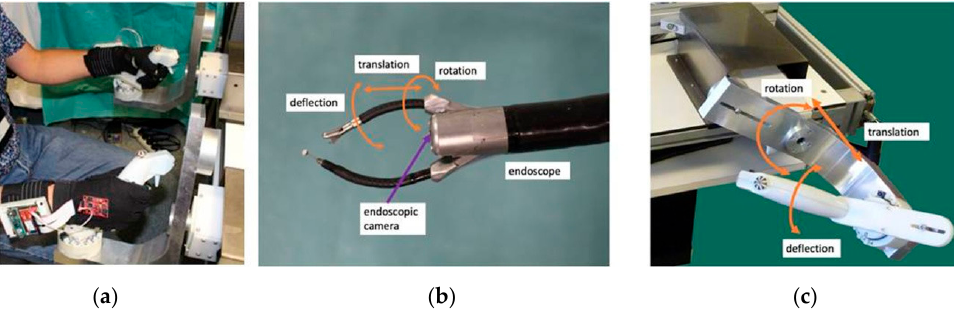
Figure 2. Expert wearing the sensor gloves while manipulating the robotic master / slave system ( a ). Master-slave control chart of the master / slave system ( b ). Direction and type of tool-tip and control movements ( c